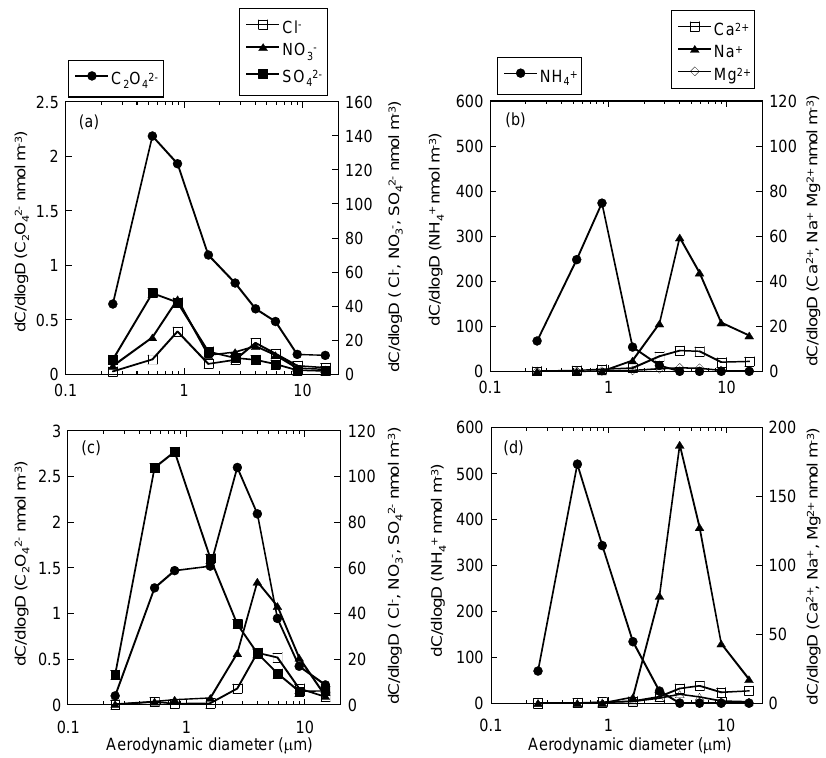
Fig. 2. Size distribution of WSCs in aerosols at Tsukuba: (a) anions and (b) cations in winter; (c) anions and (d) cations in